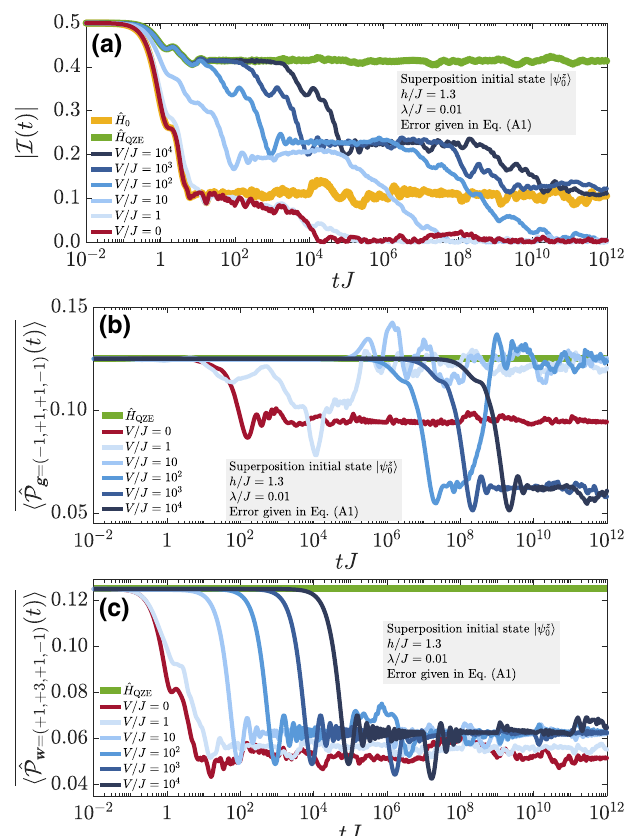
FIG. 9. Quench dynamics with the gauge-breaking term given in Eq. (A1), which involves no gauge-invariant processes. (a) The time evolution of the imbalance is qualitatively identical to the case of error (3) of Fig. 4(b) except for the timescale of the second prethermal plateau, which ends at t ∝ V /λ 2 , in agreement with the analytic earliest-time prediction, rather than t ∝ V 2 /(λ 2 J ) as in the case of error (3). (b) Same as Fig. 5(a) but for the error given in Eq. (A1). The same qualitative differ- ˆ P (cid:3) ence occurs as in the second plateau of the imbalance, with (cid:6) g deviating from its initial value at a timescale ∝ V /λ 2 rather than ∝ V 2 /(λ 2 J ) . This makes sense as the second prethermal plateau of the imbalance signifies an effective theory with only the Z 2 gauge symmetry conserved. (c) Same as Fig. 5(c) but with the gauge-breaking term (A1). The result is qualitatively unchanged ˆ P ˆ H (cid:3) is only weakly dependent on λ ˆ H since (cid:6) 1 , since 0 is the w main term that breaks the enhanced local symmetry associated with ˆ W j